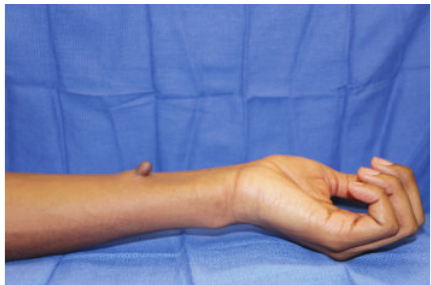
Figure 2: Lateral view of forearm.